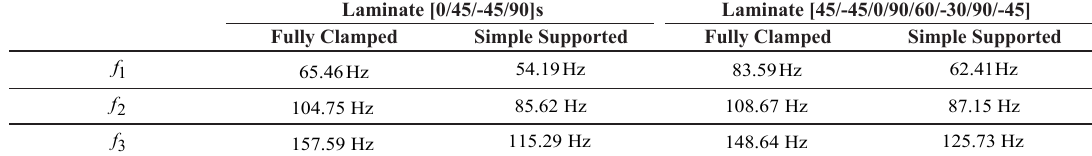
Table 5. Modal response i f for the undamaged composite panels.